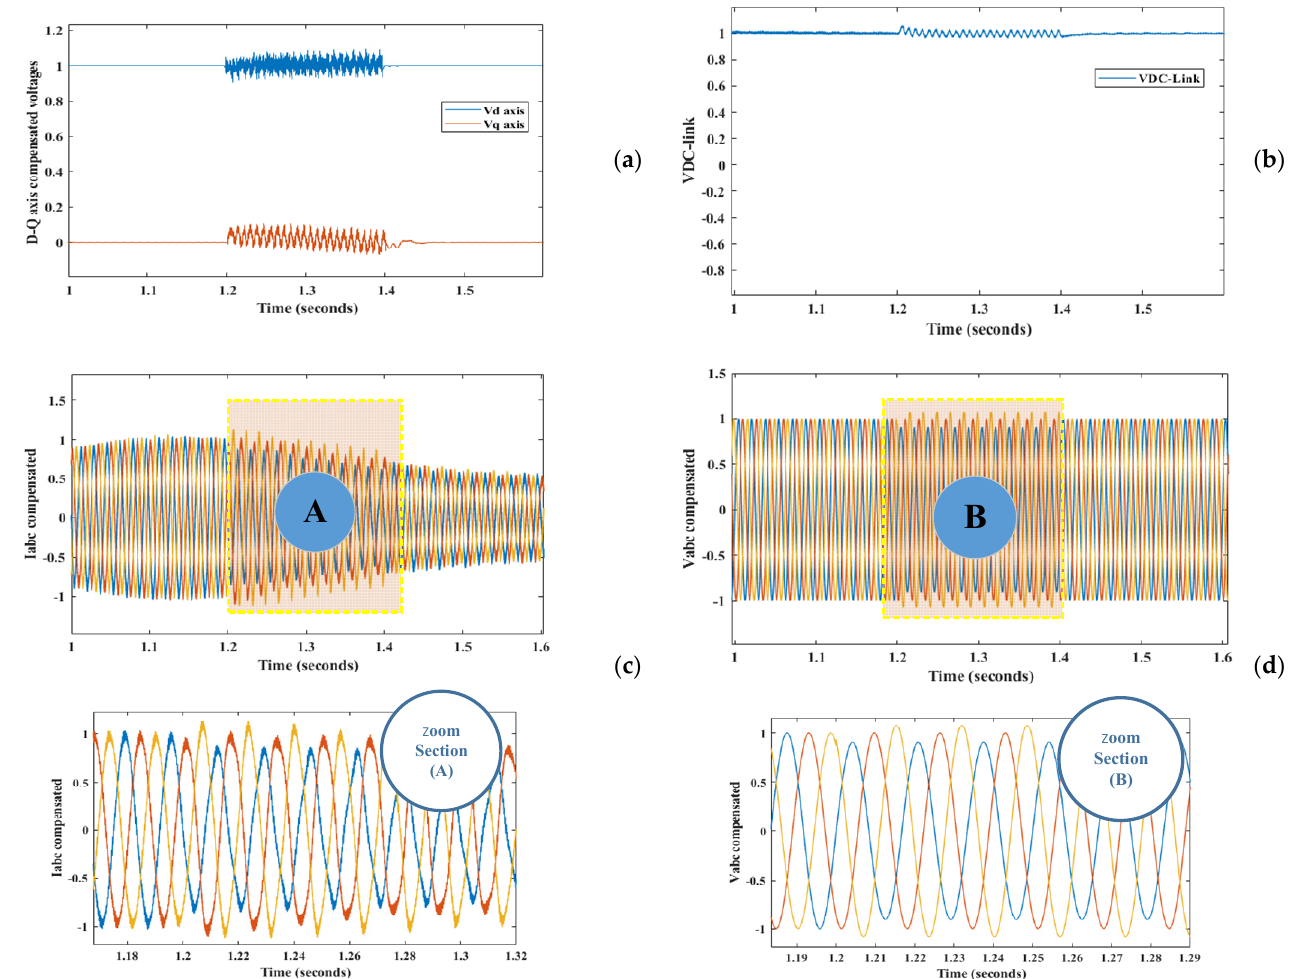
Figure 9. Simulated results of the conventional technique using the crowbar as the DC-link voltage compensator, ( a ) compensated dq voltages, ( b ) regulated DC Link voltage, ( c ) grid currents, and ( d ) compensated grid voltages.